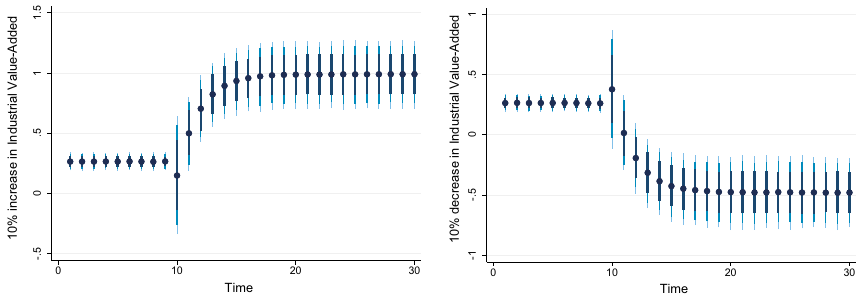
Fig. 6 The Impulse Response Plot for Industrial Value-Added and CO 2 Emissions. Figure 6 presents an increase and a decrease by 10% in industrial value-added and its effect on CO 2 emissions where dots denote average prediction value. The dark blue to light blue line shows 75, 90, and 95% confidence interval, respectively